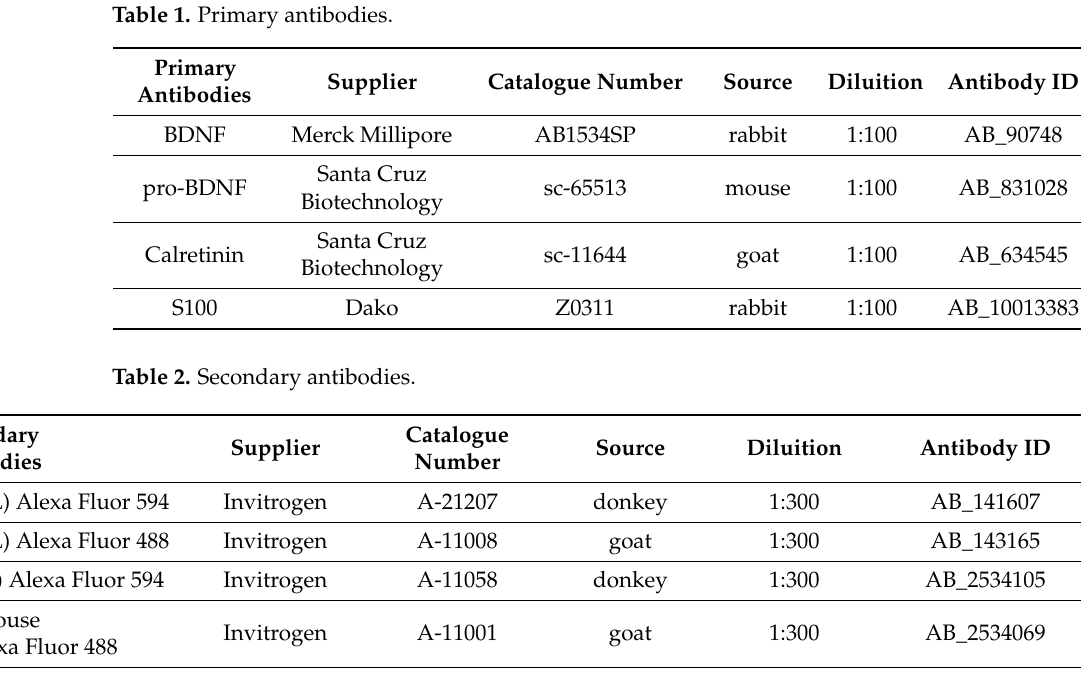
Table 1. Primary antibodies.